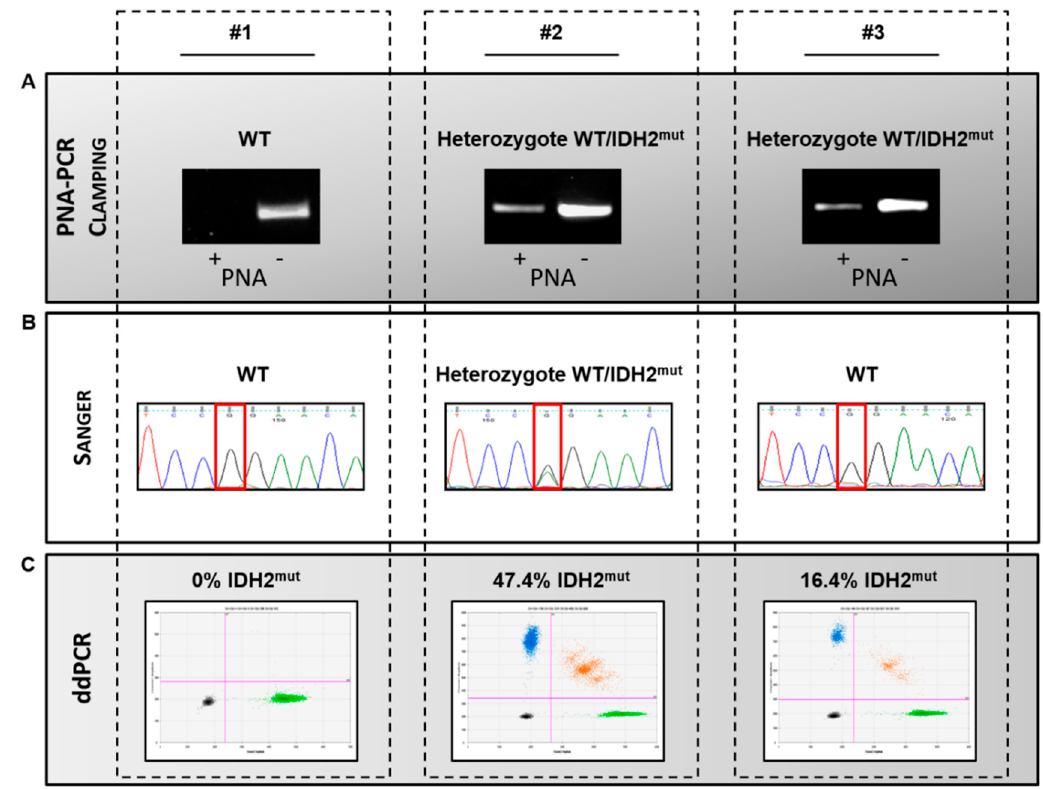
Figure 4. Comparison of techniques for IDH2 status evaluation in three patients affected by AML. ( A ). Electrophoretic runs of PNA-PCR clamping carried out in absence (PNA − ) or in presence (PNA+) of the PNA probe. The results, read in duplicate, are: IDH2wt (#1), no amplification in (+) and amplification in ( − ); IDH2mut (#2 and #3), amplification in both ( + ) and ( − ). ( B ). Sequencing chromatograms: red boxes indicate nucleotide affected by IDH2 R140Q mutation. Black peak indicates WT nucleotide (G) in #1 and #3; while double peak black and green (G/A) indicate IDH2 R140Q heterozygous mutation in #2. ( C ). 2D plots of ddPCR analysis. For each plot, the amplitude in channel 1 ( IDH2 R140Q) is represented on the y -axis with the amplitude in channel 2 ( IDH2 WT) represented on the x -axis. Four clusters are identified as single-positive for IDH2 mutated ( blue ) and IDH2 wild type ( green ), double-positive ( orange ) and double-negative ( grey ). The percentages of IDH2 R140Q / IDH2 WT are indicated in each 2D plot.